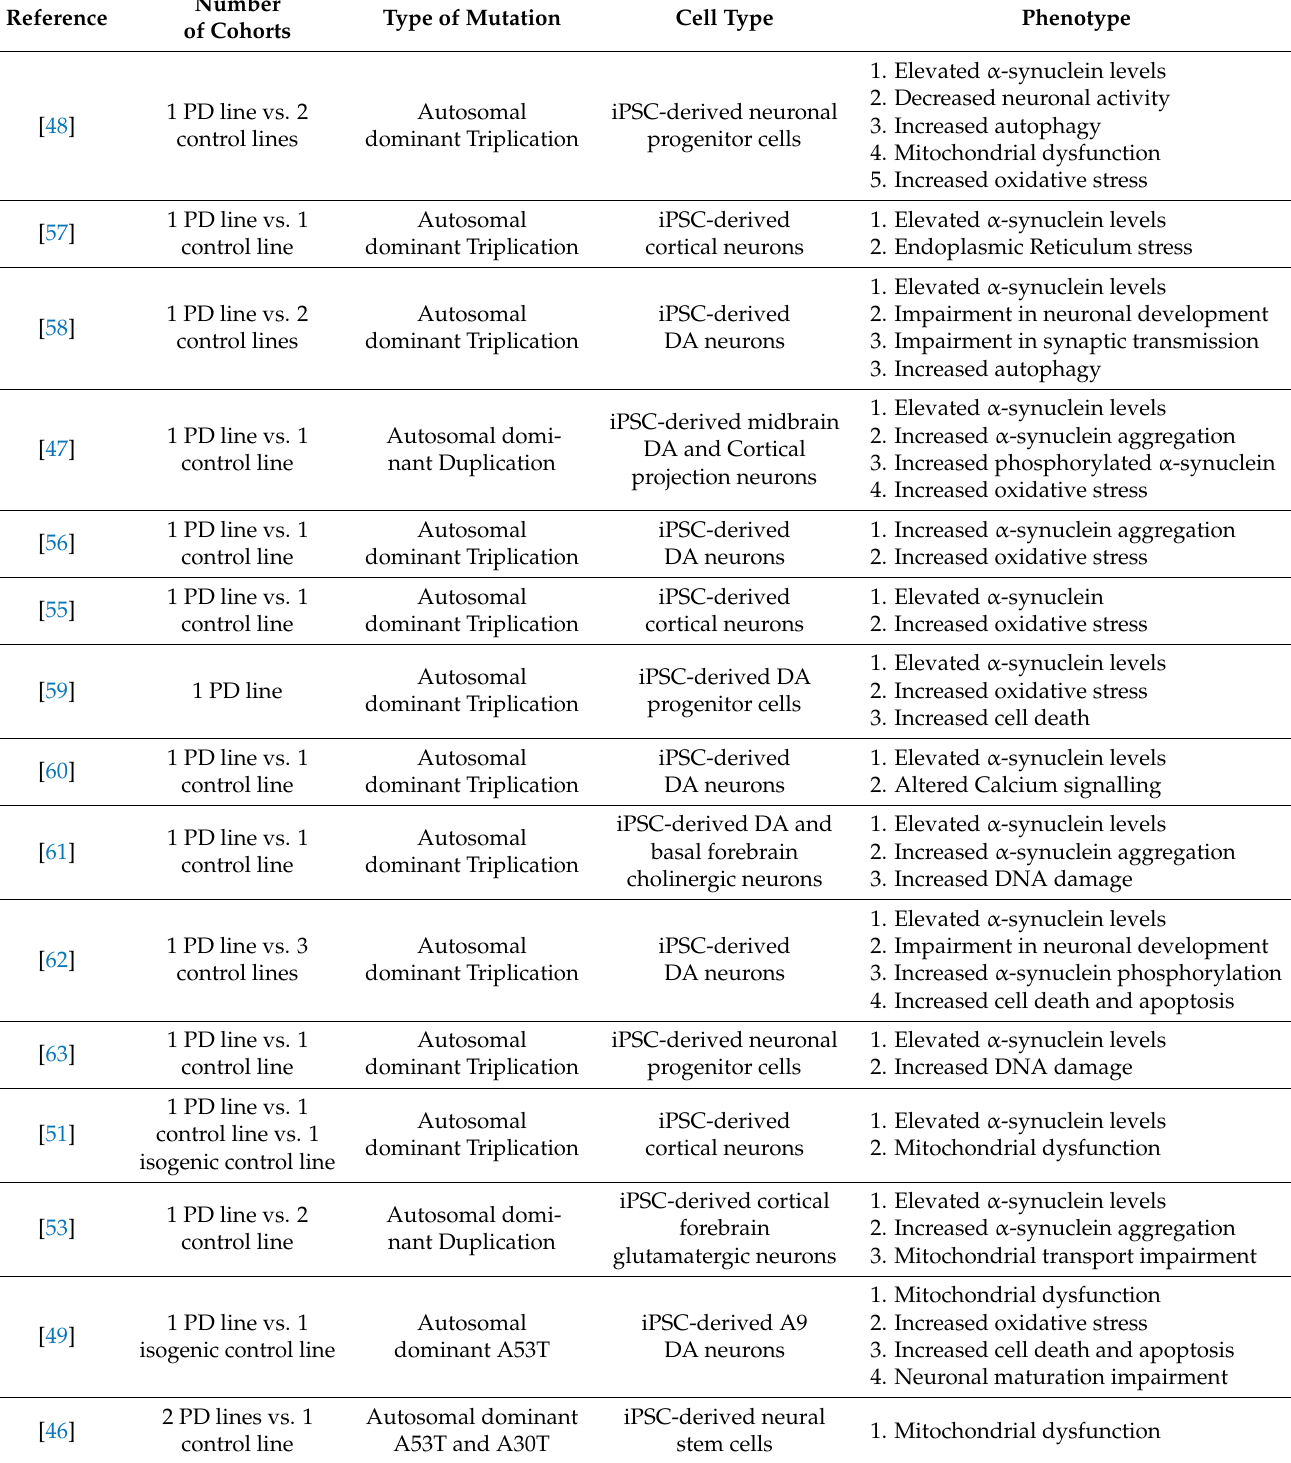
Table 1. SNCA -mutated iPSC-derived neuronal